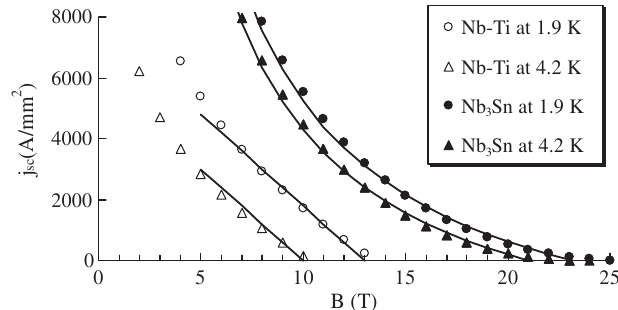
FIG. 1. Critical surface for Nb-Ti: fit of Eq. (1) (empty markers), and linear fit (solid line) of Eq. (2). Critical surface for Nb Sn : fit of Eq. (3) (full markers), and hyperbolic fit (solid 3 line) of Eq.